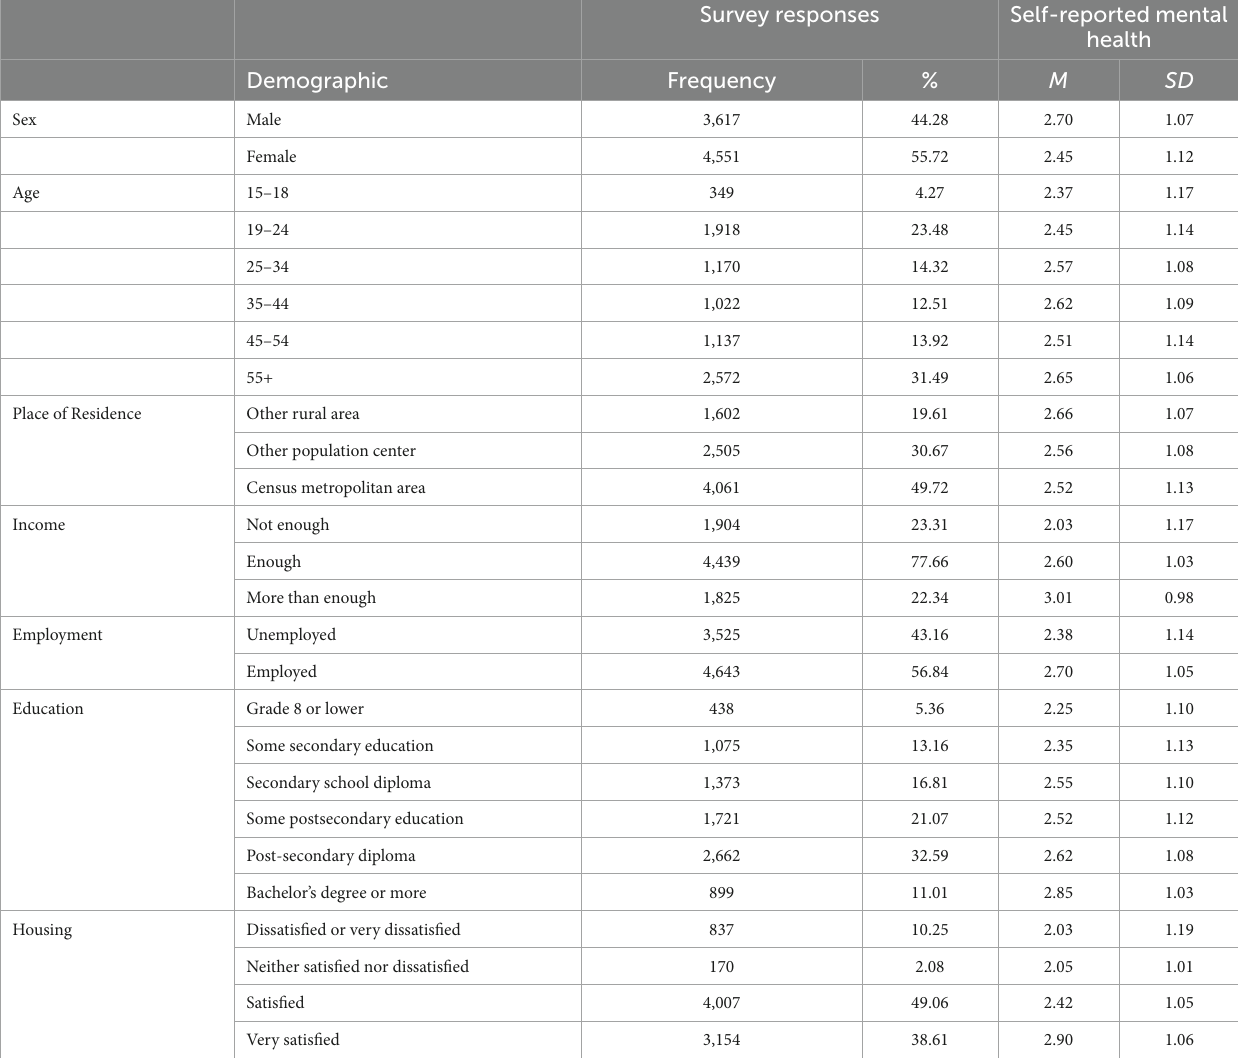
TABLE 1 Participant demographics and ratings of self-reported mental